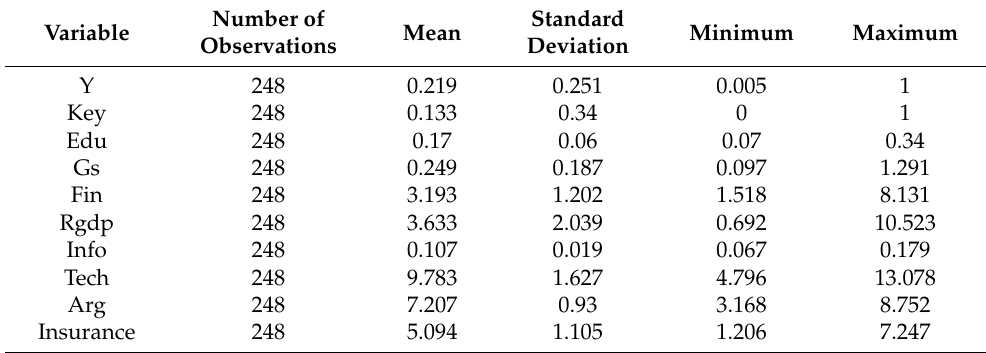
Table 1. Descriptive statistics of